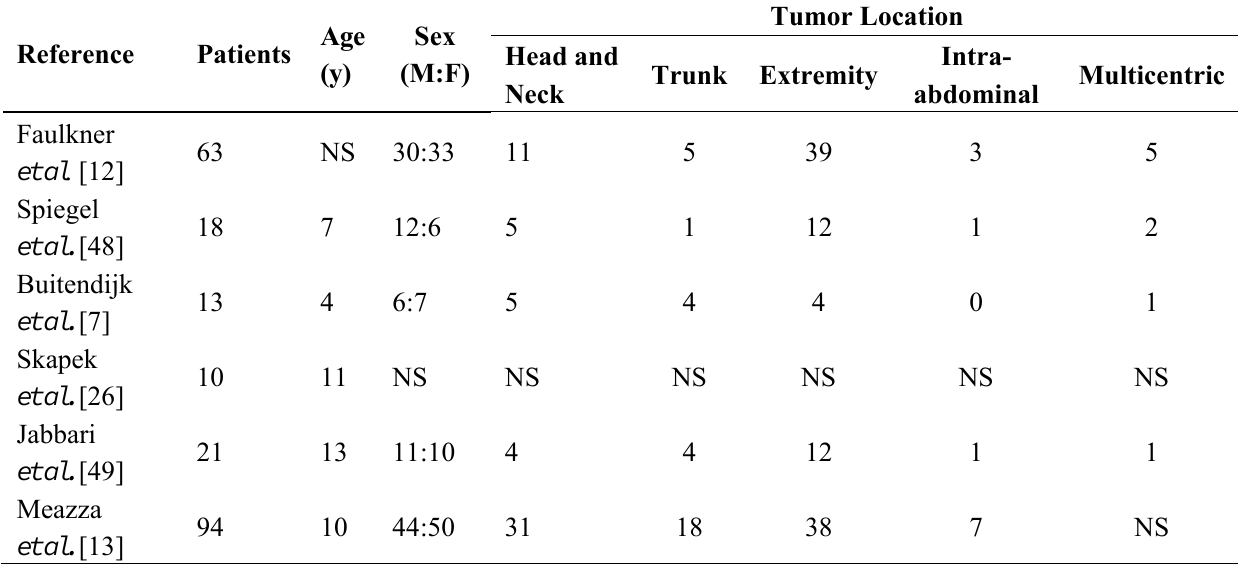
Table 1. Literature review: Demographics and tumor